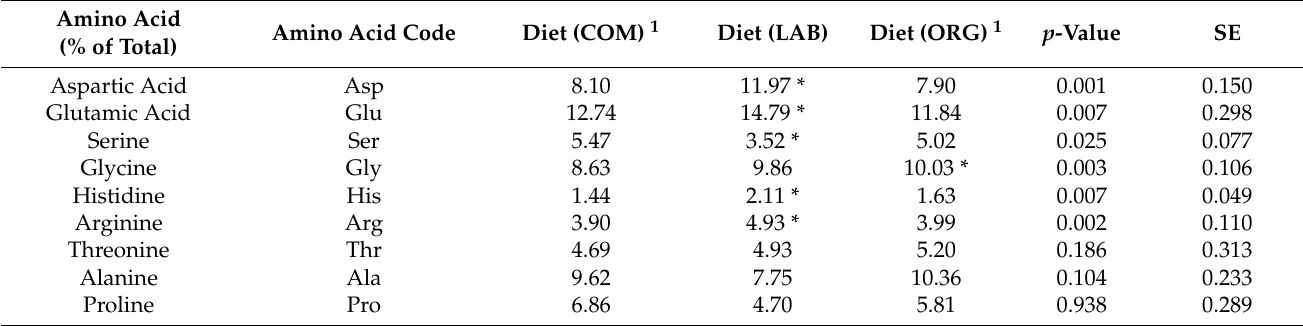
Table 1. Amino acid composition (% of total) of the experimental diets and bound essential A/E ratio of white muscle (WM), liver (L) and gut (G) of wild sea bream and gut free essential A/E ratios of sea bream fed the experimental diets. Amino Acid (% of